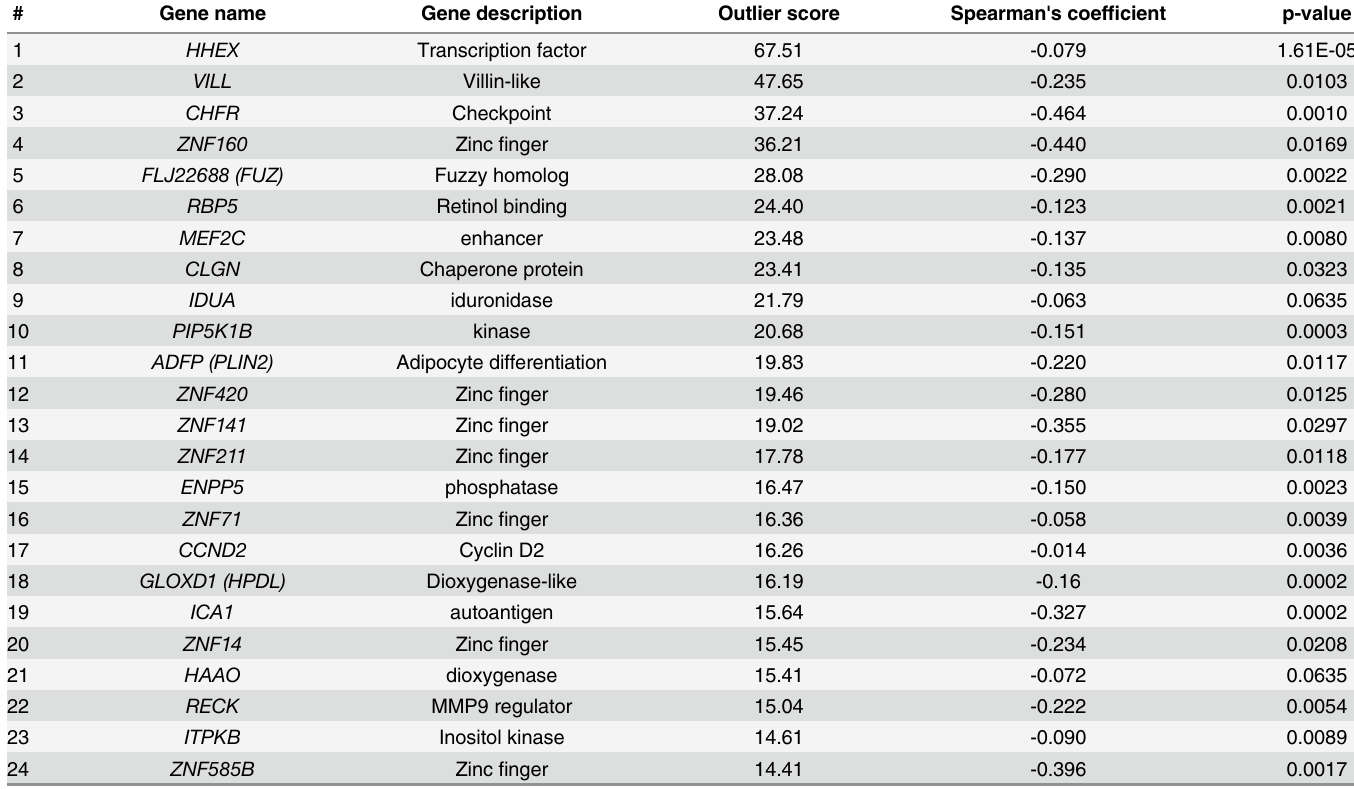
Table 1. Twenty four DNA methylation biomarker